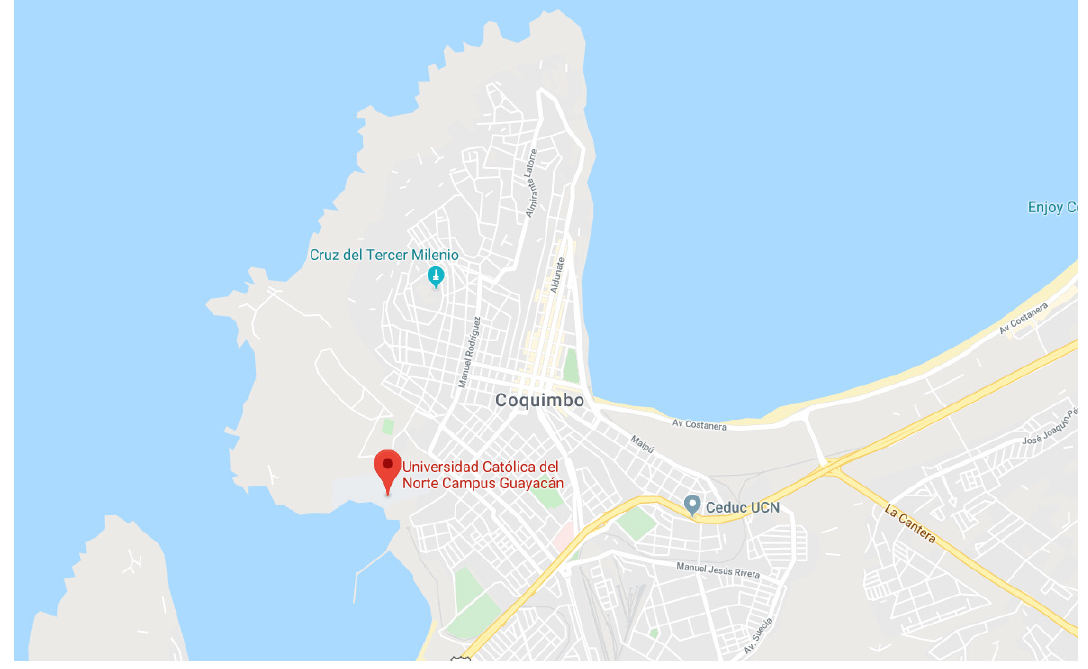
Figure 2. The location Universidad Catolica del